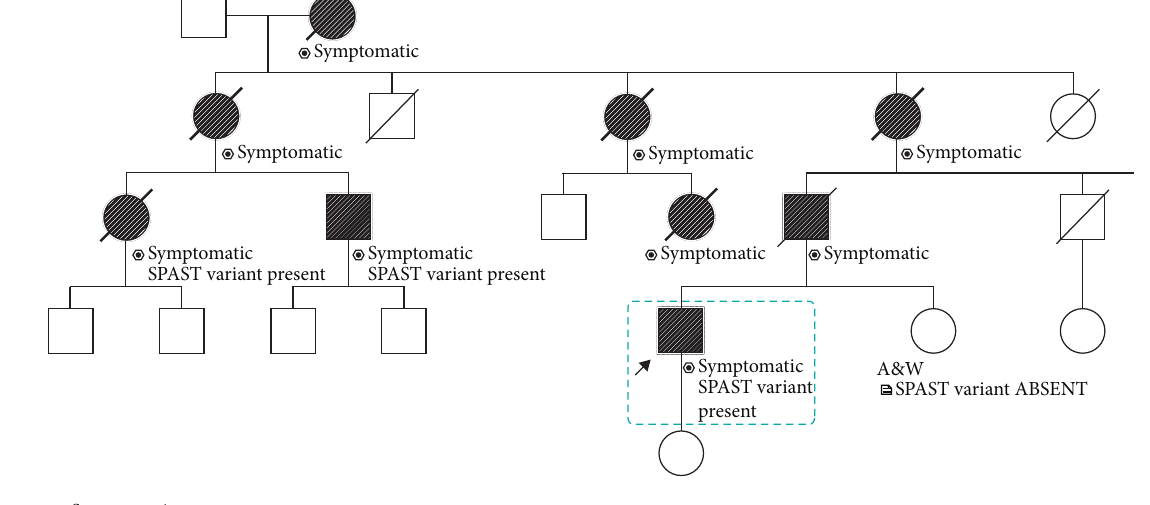
Figure 1: Pedigree of the